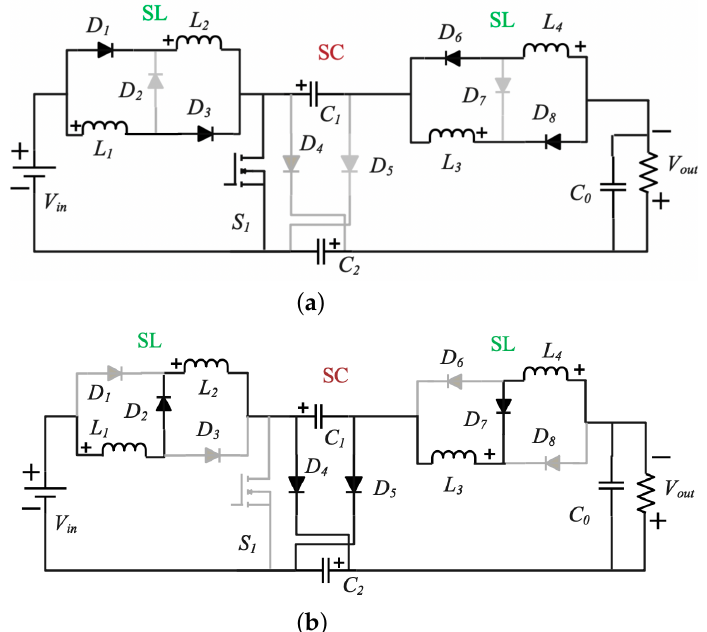
Figure 9. Topology 3: Operating mode of SLSC CUK converter ( a ) ON Mode ( b ) OFF Mode. Design Analysis of